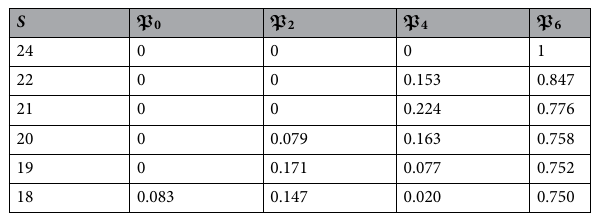
Table 4. The set { P (cid:31) } of the p-p states ( [ 7 ] χ) S of H (cid:31) with N = 8 and f = 3 different in S . In all these states, due to the fully polarized 7-body core, P 6 is dominant. However, when S decreases more from 3 × N = 24 , the direction of the single spin deviates more from that of the fully polarized core, and therefore leads to a smaller P 6